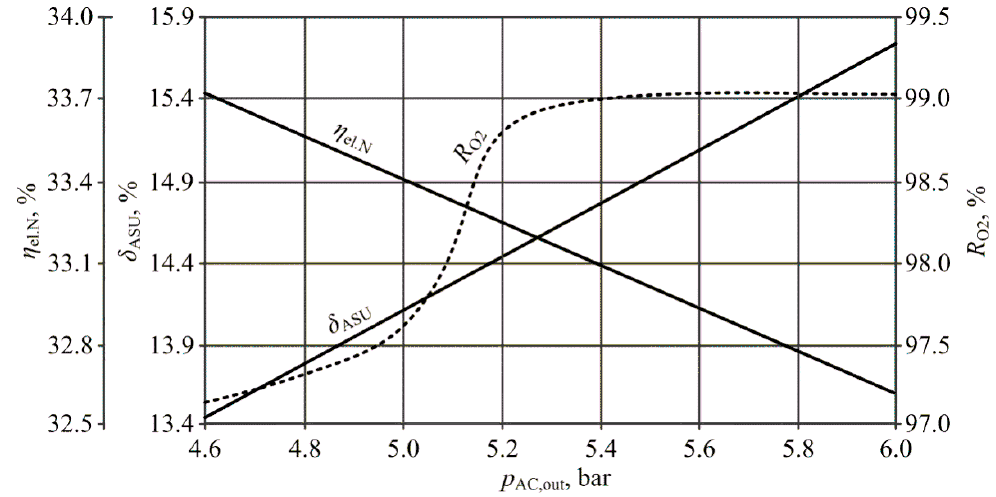
Figure 8. Variant V1 power plant net efficiency, auxiliary power rate of the ASU and the oxygen recovery rate as a function of the air compressor’s outlet pressure.